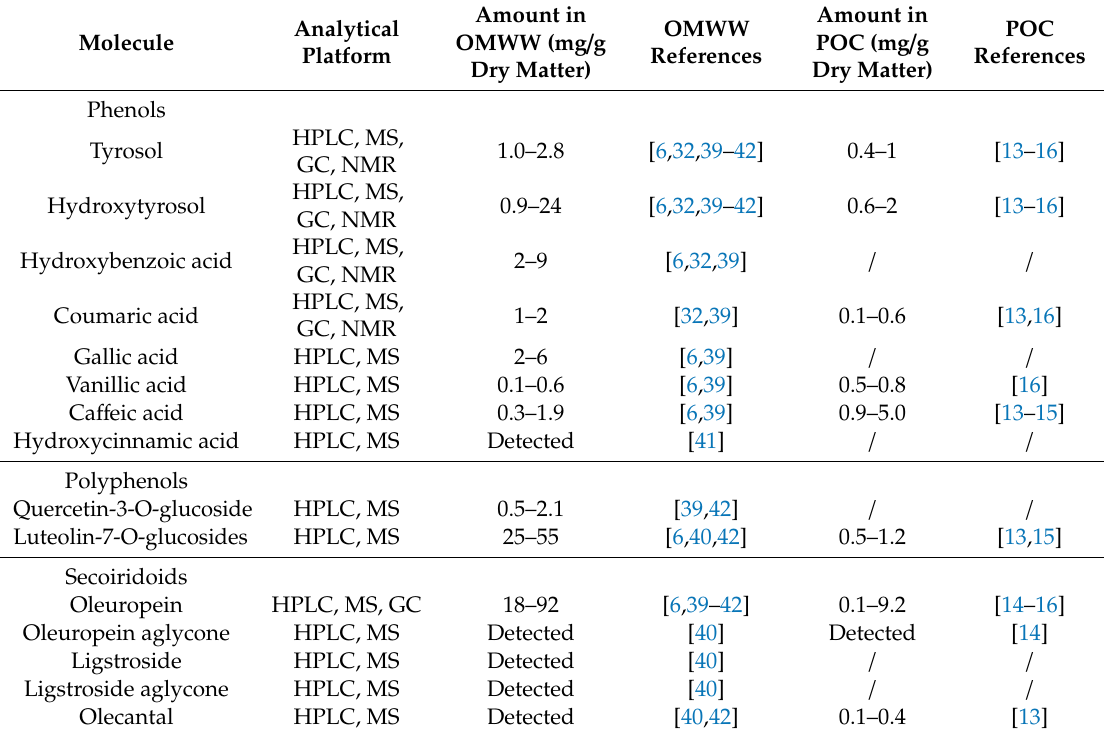
Table 1. Recent studies on the characterization of bioactive phenolic compounds in olive mill wastes